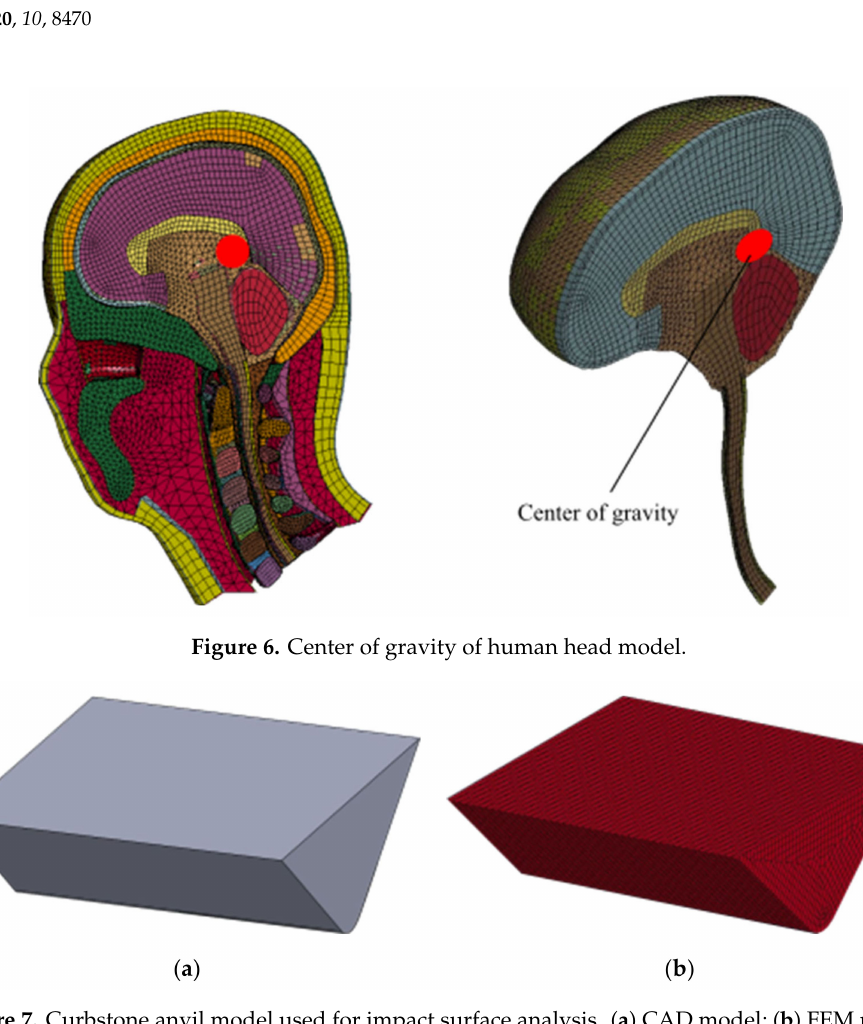
Figure 7. Curbstone anvil model used for impact surface analysis. ( a ) CAD model; ( b ) FEM model.